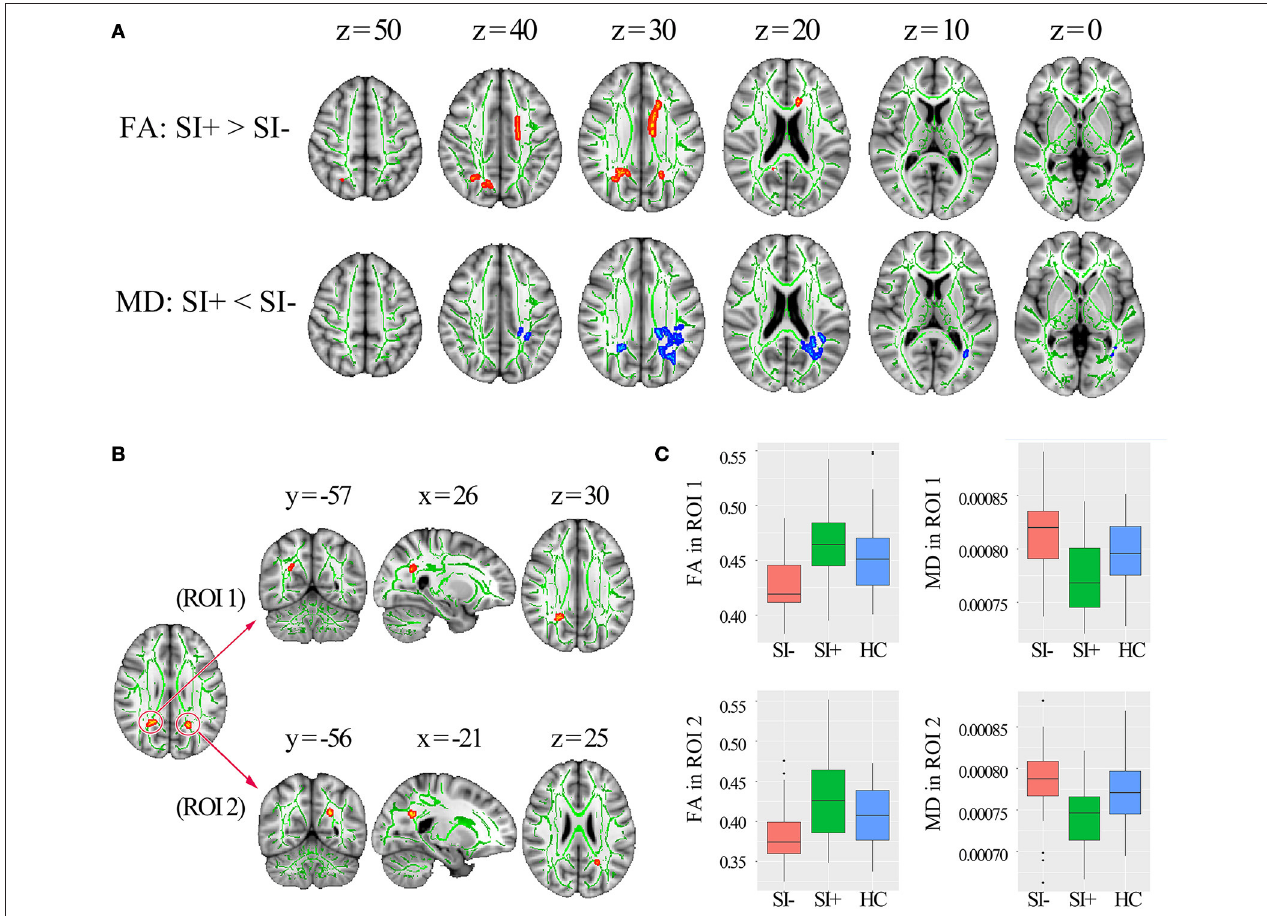
FIGURE 2 | The TBSS results comparing the FES patients with (SI + ) and without (SI–) suicidal ideation. (A) The differences in FA and MD ( p < 0.05, corrected) between SI + and SI–, marked in orange (higher in SI + ) or blue (lower in SI–) with underlying WM skeleton marked in green. (B) Two regions of interest (ROI) located in right and left posterior corona radiata identified by overlapping the brain regions with FA and MD differences between SI + and SI. (C) Mean FA and MD values extracted from right posterior corona radiata (ROI 1) and left posterior corona radiata (ROI 2) in the groups of SI + , SI–, and healthy controls (HC) respectively. FA, fractional anisotropy; MD, mean diffusivity; x, y, z, MNI